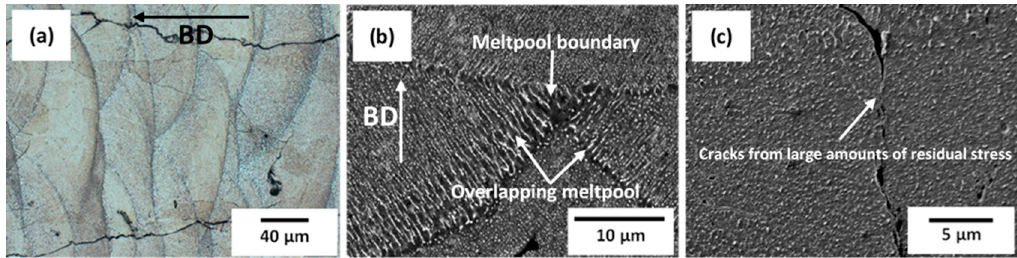
Figure 3. As-built LPBF microstructures: ( a ) Observed under Light Optical Microscope (LOM), ( b ) observed under Scanning Electron Microscope (SEM), showing melt-pool boundary and melt-pool boundary overlaps and ( c ) observed residual stress-induced cracks in the as-built condition.